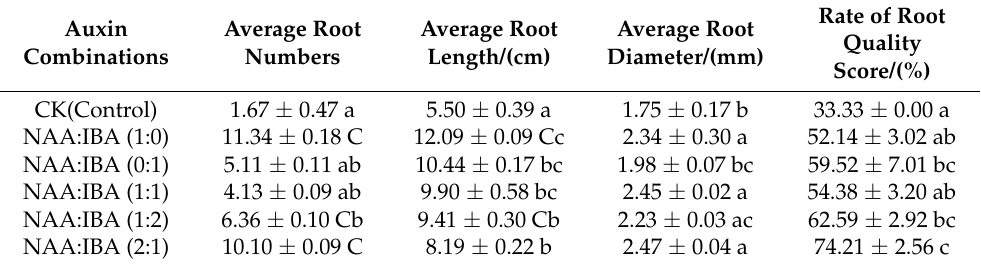
lowercase letter, at p < 0.05 between two lowercase letters.